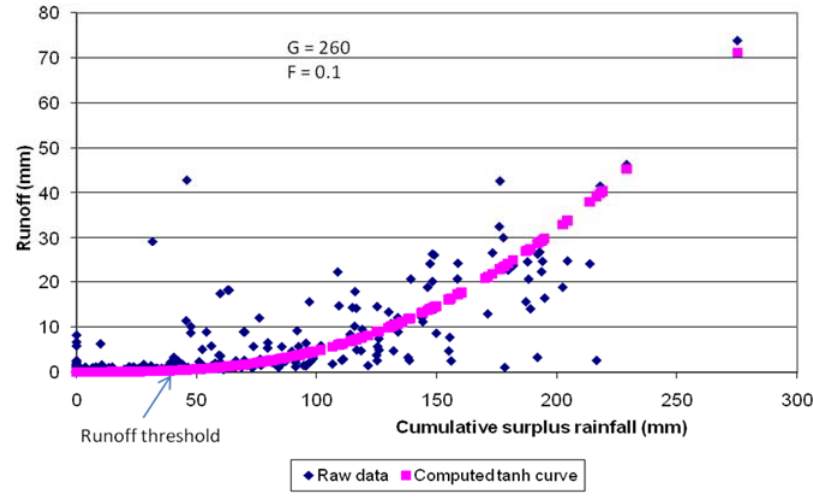
Figure 10. Stream flow modeling for the Grange Burn at Morgiana (gauge no. 238219). The location of the gauge station is shown in Figure 1.